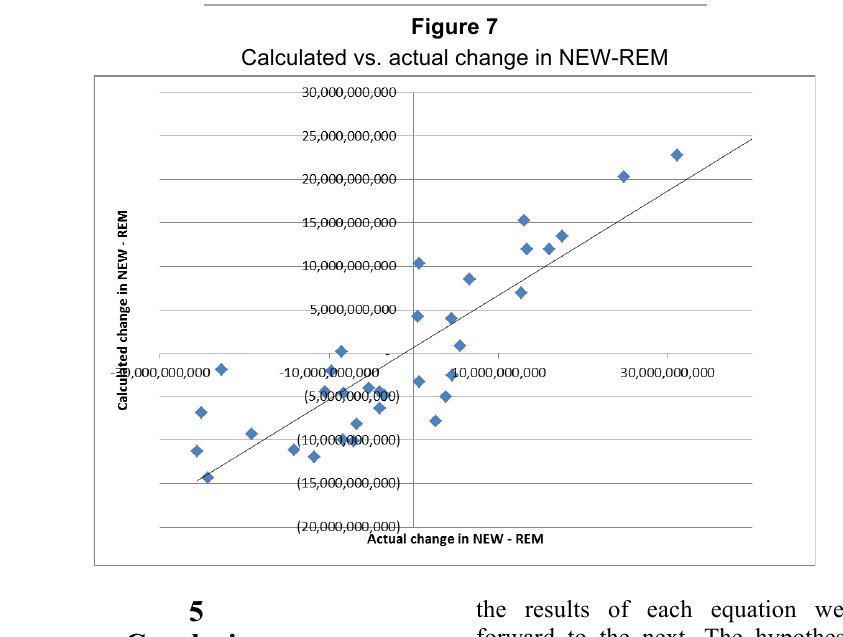
Calculated vs. actual change in